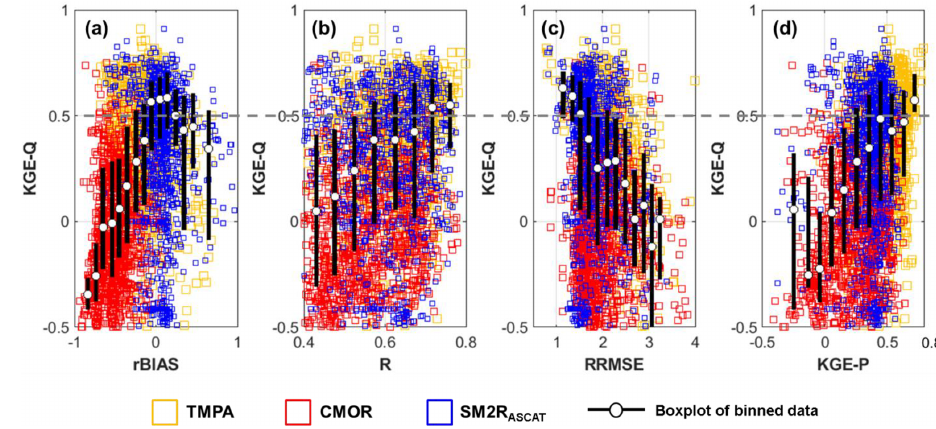
Figure 4. Performances of discharge in terms of KGE (KGE- Q ) against (a) relative rainfall bias – rBIAS; (b) rainfall correlation – R ; (c) relative root mean square error of rainfall – RRMSE; and (d) KGE- P . The scores are evaluated for the validation period (2013–2016) for all the 1318 basins.